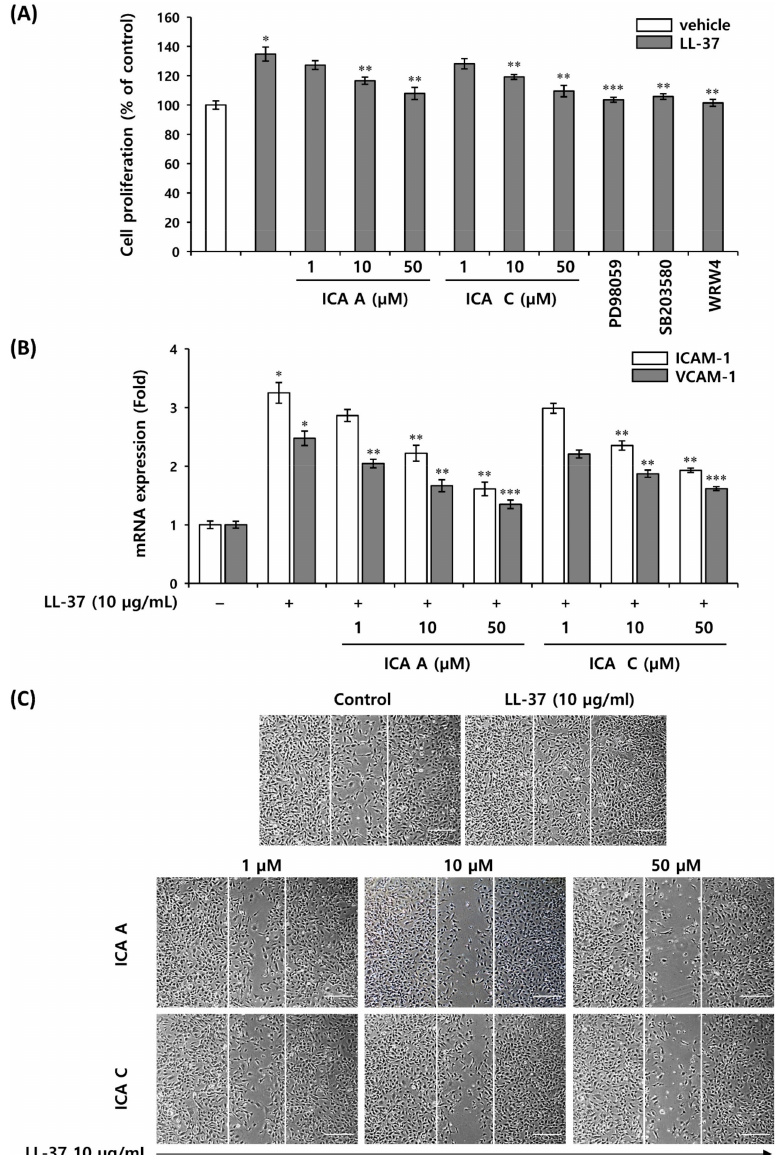
Figure 6. Chlorogenic acid isomers inhibit vascular endothelial cell activation. HMEC-1 was pre- treated with isochlorogenic acids A, isochlorogenic acid C, 20 µ M ERK1/2 inhibitor, 10 µ M p38MAPK inhibitor, and 10 µ M FPRL1 antagonist for 1 h, and subsequently treated with 5 µ g/mL LL-37. ( A ) Cell proliferation was measured using the WST1 assay. ( B ) The expression of cell adhesion molecules, ICAM-1 and VCAM-1 mRNA was measured by quantitative real-time PCR. ( C ) Cell migration was measured using scratch migration assay. Representative image of the inhibition of cell migration by isochlorogenic acids and C, compared with vehicle-treated control; scale bars are 100 µ m. The results are expressed as mean ± standard deviation (SD) ( n = 3). * p < 0.01 vs. vehicle control; ** p < 0.05 vs. LL-37-treated control; *** p < 0.01 vs. LL-37-treated control. ICA A, isochlorogenic acid A; ICA C, isochlorogenic acid